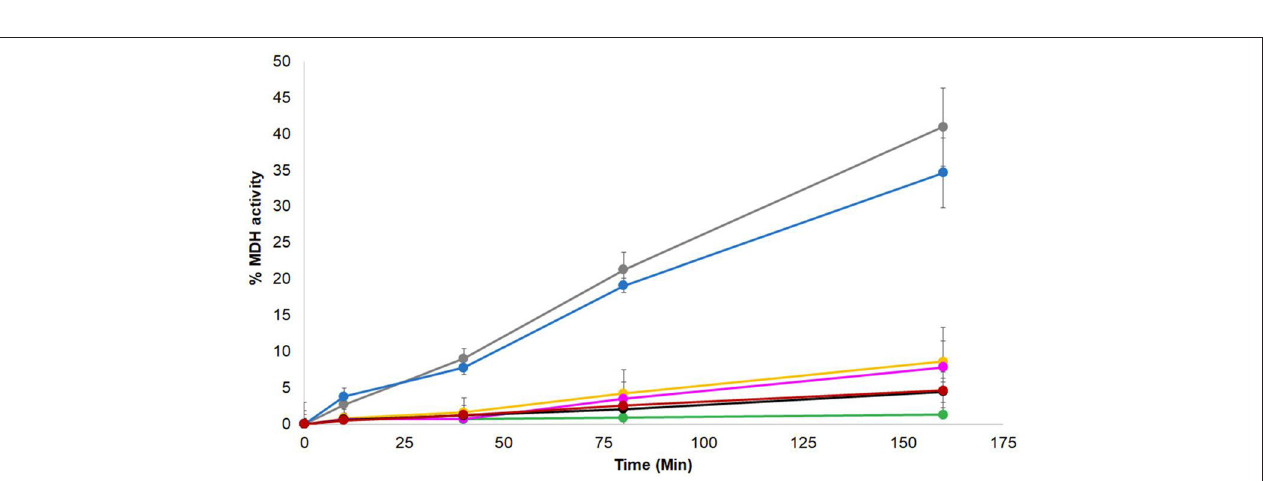
FIGURE 5 | GSSG promotes refolding of reduced and denatured RNaseA. RNaseA was reduced and denatured as described in Figure 2 . Refolding of reduced and denatured RNaseA was initiated by its dilution (200-fold) into renaturation buffer to a final concentration of 50 µ g/mL. Refolding of RNaseA was either spontaneous and measured in the absence of oxidized glutathione, GSSG, ( • ), or in the presence of a mixture between GSSG (100 µ M) and changing concentrations of reduced glutathione that ranged between 0 µ M ( • ), 33 µ M ( • ), 100 µ M ( • ), 300 µ M ( • ), and 1,000 µ M ( • ). The percentage of refolding was calculated relative to native RNaseA activity. Similar results were obtained in two independent replicate experiments.